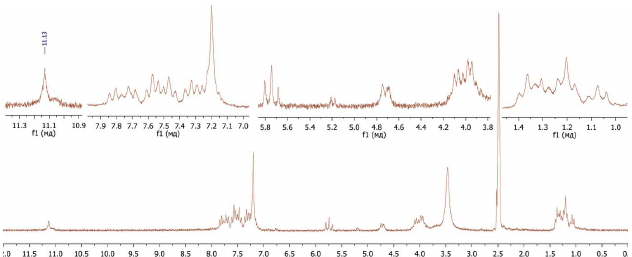
Figure 3 1 H NMR spectrum of 7 in DMSO- d